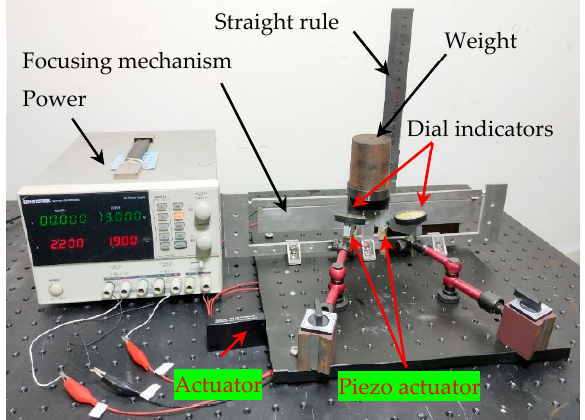
Figure 9. The experimental platform of the focusing mechanism based on a two-stage flexural hinge lever-type mechanism. The driven force is derived from the piezo actuator.